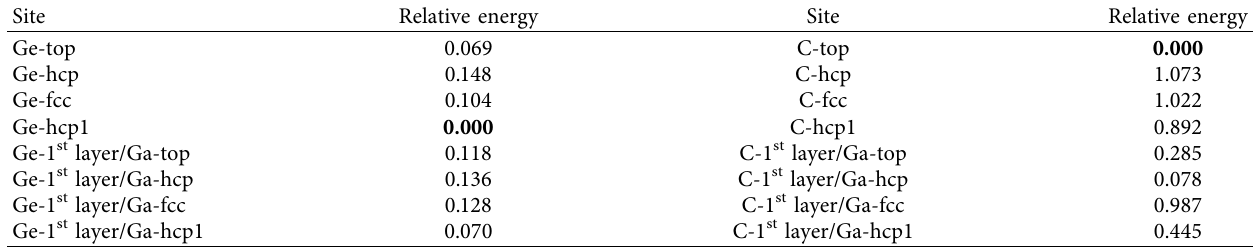
Table 1: Relative adsorption energies (eV) and the incorporation of different Ge and C coverage.